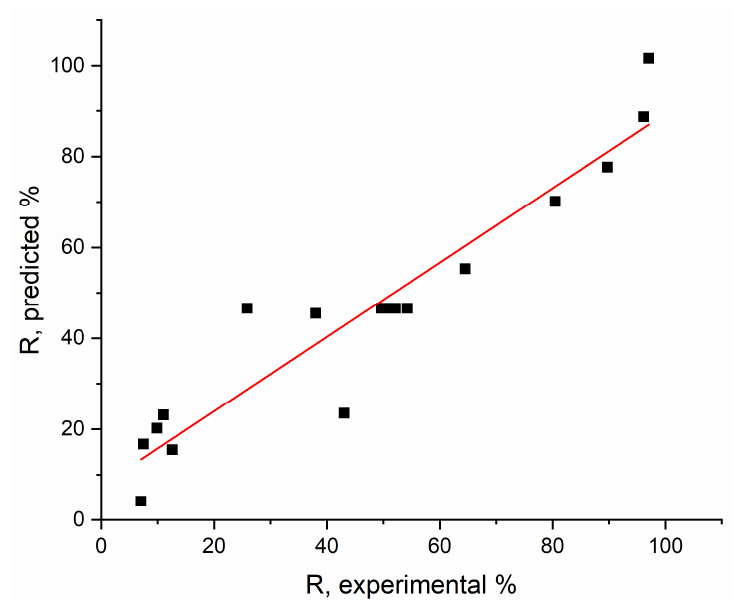
Figure 8 shows the relationship between the experimental responses and the responses predicted by the model.